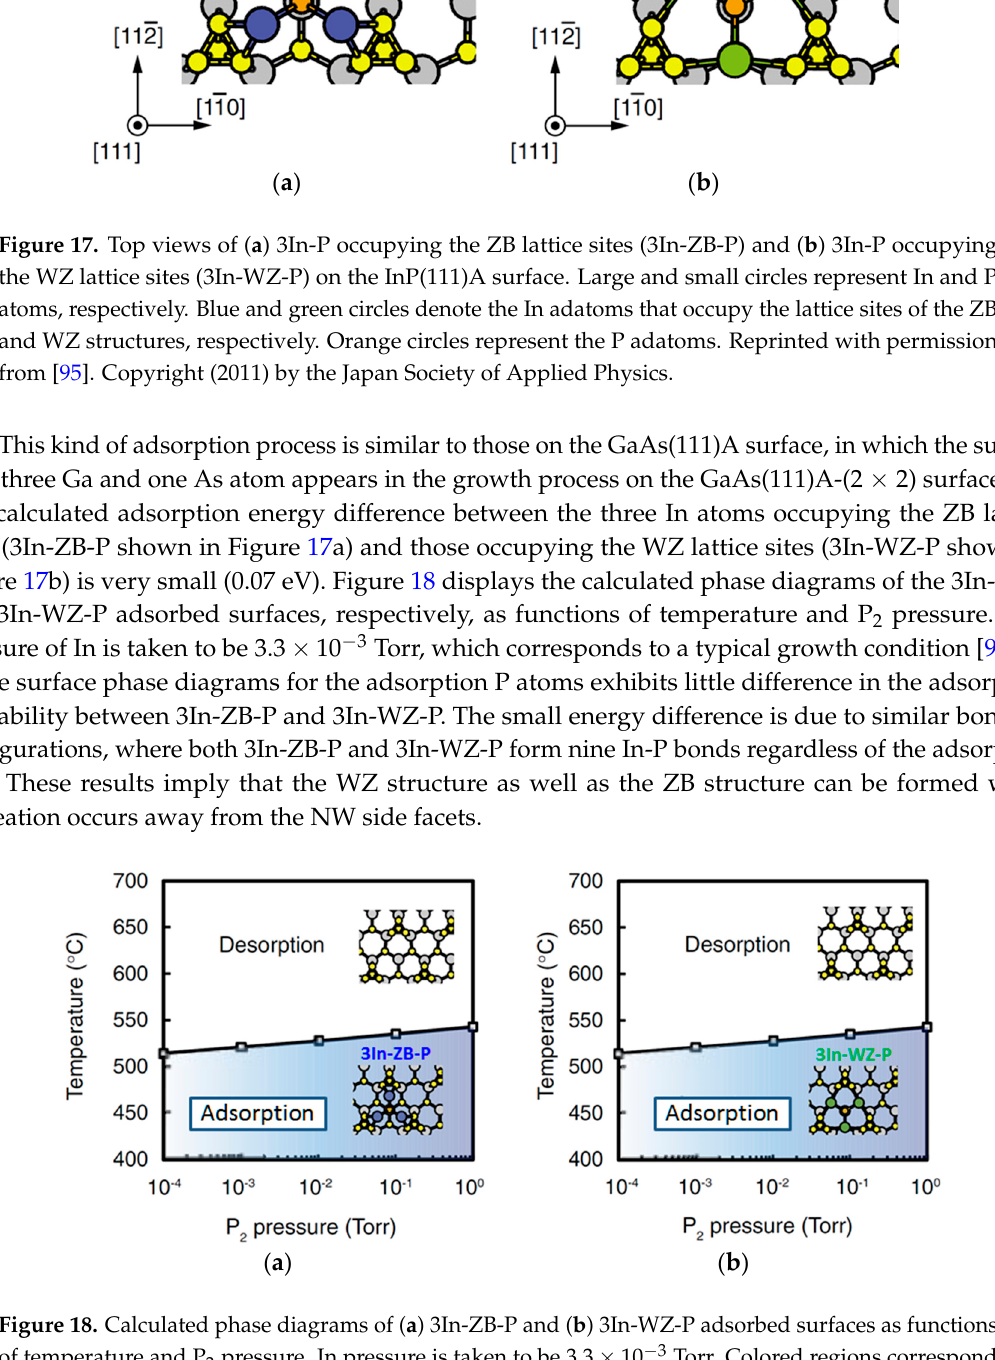
17 of 37 Figure 16. Phase diagram for crystal structure of InP NWs as functions of chemical potential difference between liquid and solid phases Δμ liquid-solid and normalized step energy difference between ZB and WZ structures ΔΓ step / Γ step , using the energy difference between ZB and WZ structures in bulk InP (6.8 meV/atom) [87] for interface energy per area between nucleus and nanowire top layer for WZ structure σ WZint . White and grey areas denote the stable regions for WZ and ZB structures, respectively. 4.2. Effect of Side Facets on Adsorption–Desorption Behaviors at Top Layers in InP NWs In order to clarify the effects of NW side facets during the SA-MOVPE, we have to consider adsorption-desorption behavior on two kinds of growth regions. One is a central area on the top layer of InP NWs, where we adopt the (2 × 2) surface with P trimer as a calculation model. It is expected that the the (2 × 2) surface with P trimer appears because it satisfies the ECM [38,39], and previous theoretical calculations also support the stabilization of the P trimer on the InP(111)A surface under P-rich conditions [94]. Since the InP NWs are grown under high P pressures [91], this surface could be a possible surface reconstruction during the growth of NWs. In addition, investigating adsorption–desorption behavior on the (2 × 2) is quite important since the adsorption site of In atoms determines the crystal structure. Another growth area we have to consider is a side area, where the calculation model of the side area consists of both (111)A and (11(cid:3364)0) surfaces. Here, we assume the (2 × 2) surface with P trimer on the top surface of the side area. For the central area of NWs, the calculated adsorption energy of P atom is a positive value (2.26 eV). This indicates that the adsorption